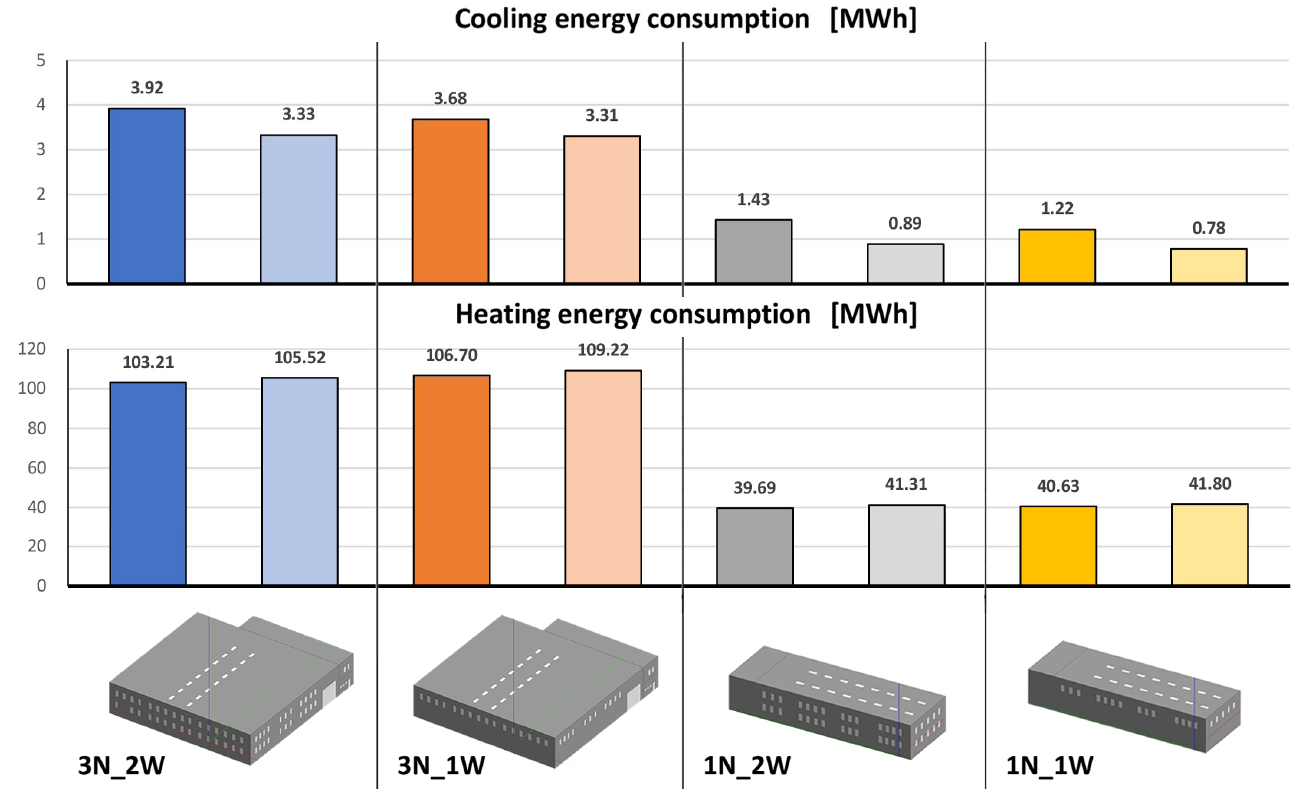
Figure 8. Yearly energy consumption (MWh) for both cooling and heating for each considered building layout, comparing the base case and the configuration with indirect green walls installed in each orientation.